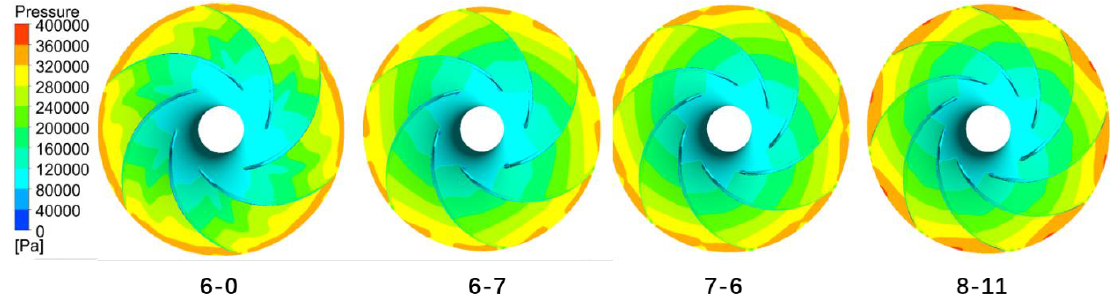
Figure 14. Static pressure distribution of high-speed pump under four computational cases.